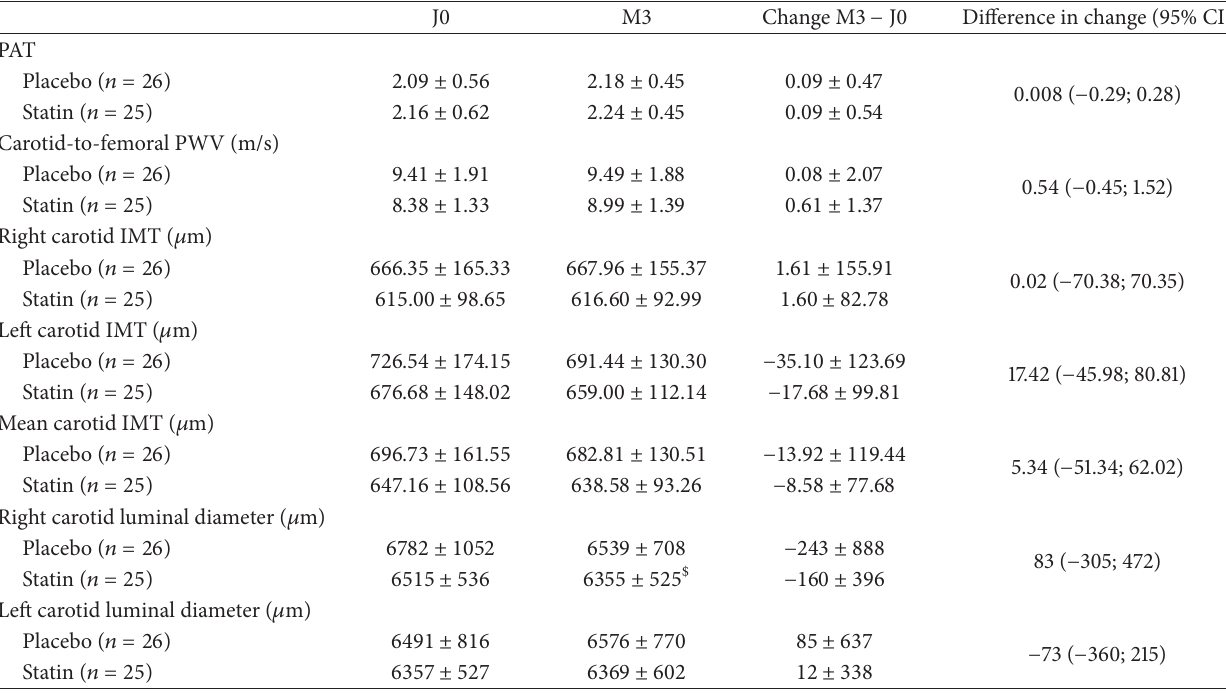
Table 2: Cardiovascular parameters at baseline (J0) and after 12 weeks (M3) of placebo or statin treatment.